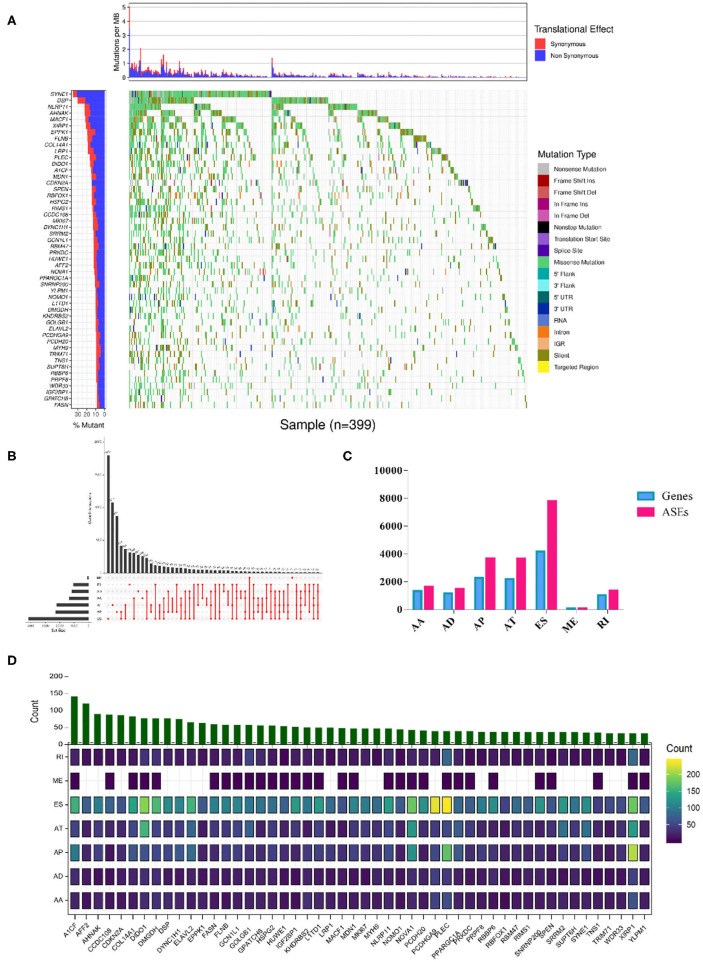
RBP mutations triggered splicing event alterations. (A) Among the 853 RBPs whose mutations showed significant correlations with aberrant ASEs (Wilcoxon test P-values < 0.01). The mutation situations of the top 50 RBPs with the highest mutant frequency were exhibited. The y-axis represents each RBP and sorted by mutation frequency. The x-axis stands for different SKCM samples. The color indicates different mutation types. The bar plot above represents the mutation frequency with synonymous (red) and non-synonymous (blue) translational effects for each SKCM patient. (B) Upset plot of each splicing pattern affected by RBP mutations. The black bar on the left side indicates the event number of specific splicing type, and the red dots on the right side represent the intersections of ASEs. (C) Distribution of seven types of ASEs and their corresponding genes. The x-axis represents each kind of ASEs (AA, AD, AP, AT, ES, ME, RI), and the y-axis represents the number of ASEs (red) or the corresponding spliced genes (blue). (D) Overview of splicing events per RBP with the highest mutation frequency. The color intensity indicates the occurrence frequency of each splicing pattern, and the above histogram represented the counts of ASEs affected by corresponding RBPs.